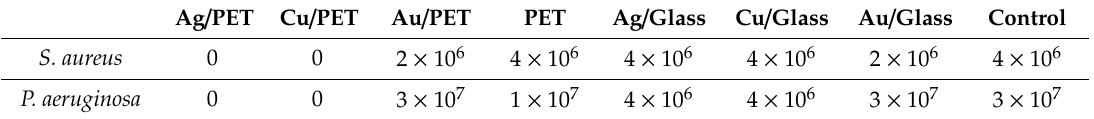
Table 2. E ff ect of transferred NPs on CFU / mL values of clinical isolates biofilms. Table 2. Effect of transferred NPs on CFU/mL values of clinical isolates biofilms.